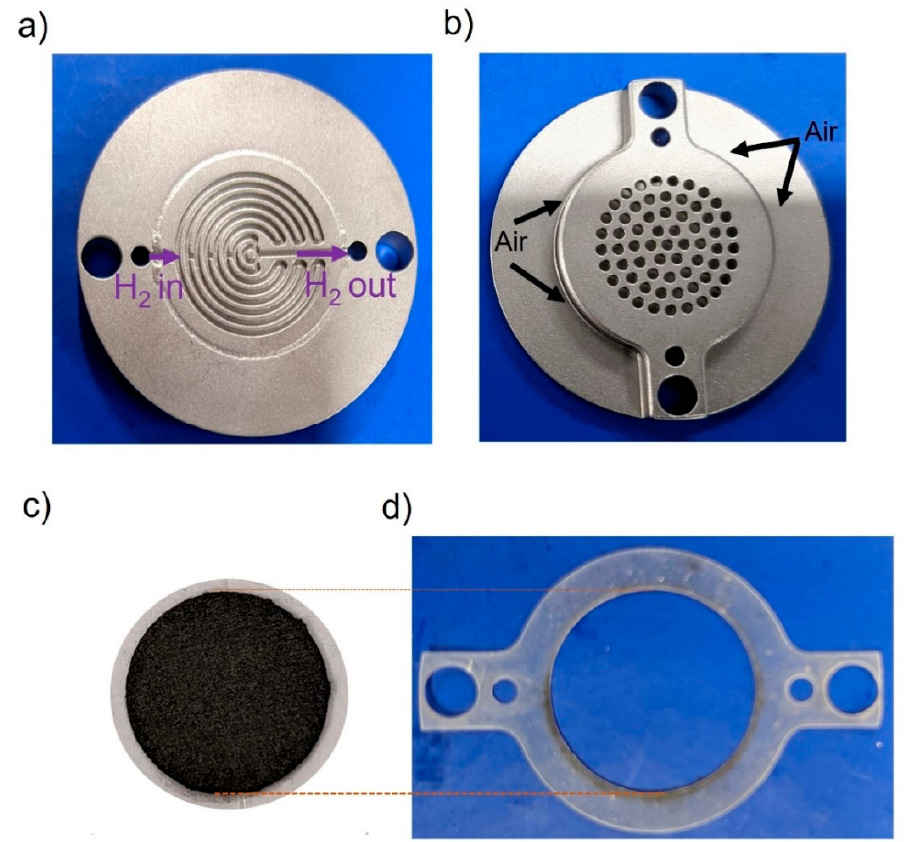
Figure 7. ( a ) Photo of the self-breathing PEMFC showing the ( a ) anode, ( b ) open cathode, ( c ) MEA, ( d ) silicon sealing gasket. ( d ) silicon sealing